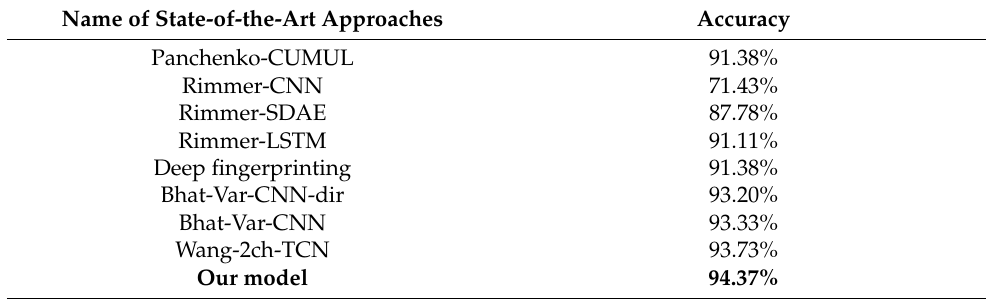
Table 4. Accuracy On Different Approaches (unaugmented Wang dataset).